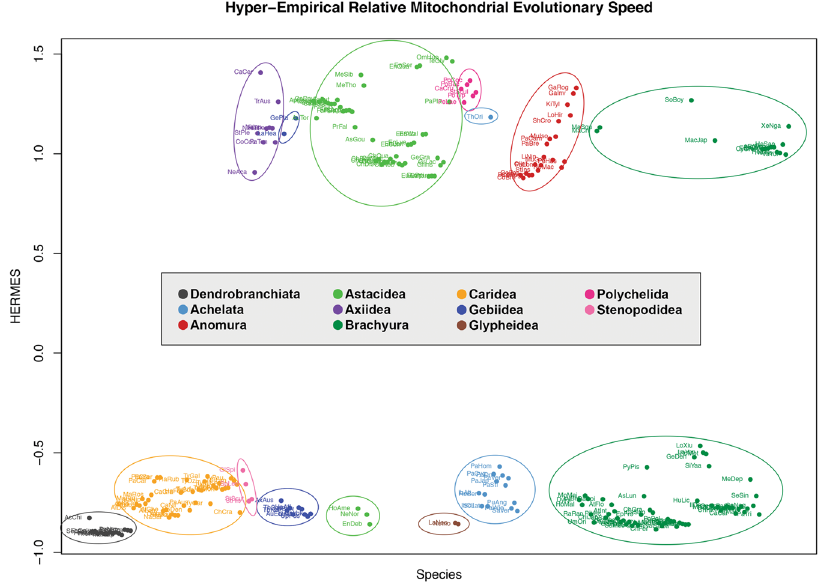
Figure 3. HERMES index across Decapoda. Species are listed horizontally by suborder, infraorder, superfamilies and families to highlight differences among various taxonomic